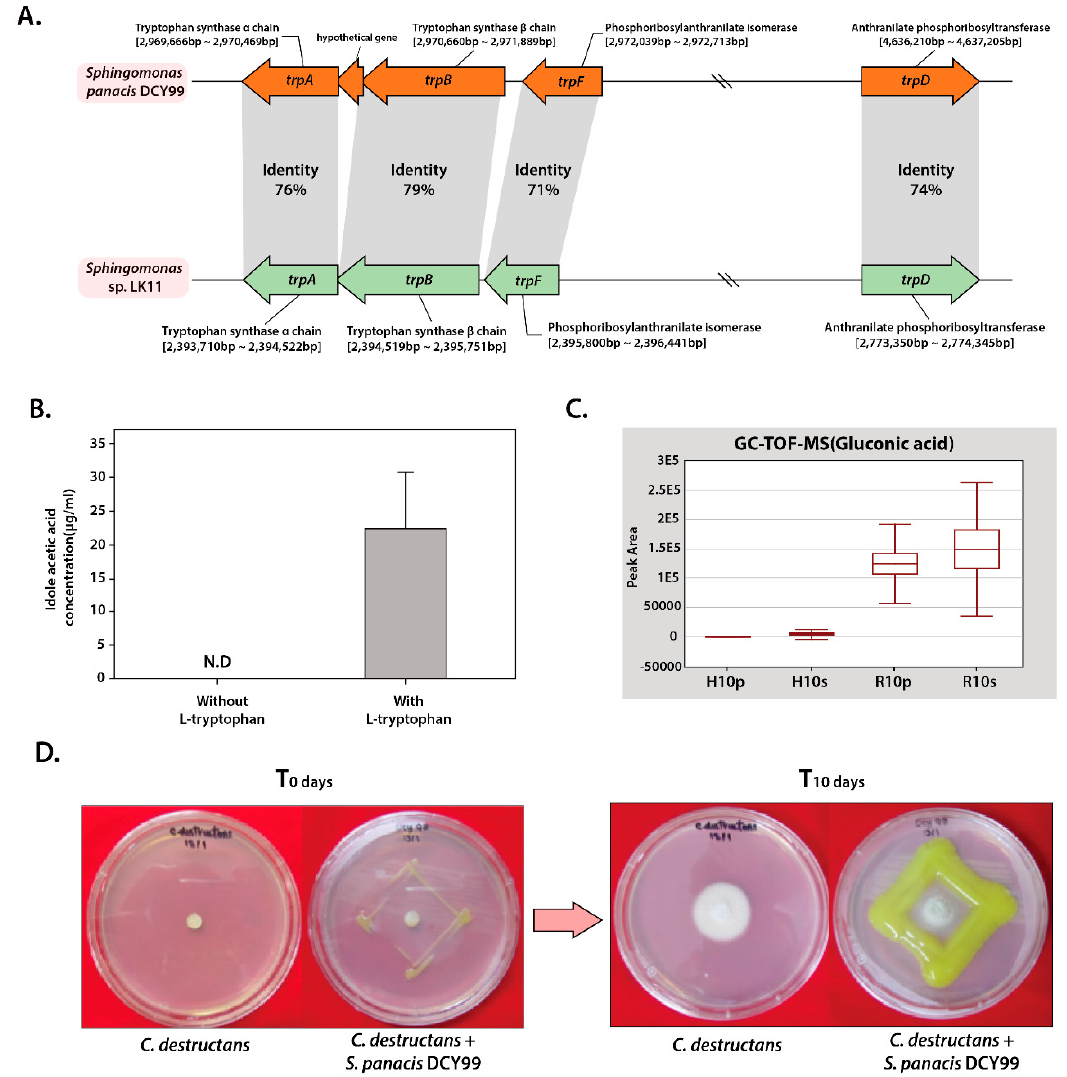
Figure 2. ( A ) Identity of trp operon between S. sp. LK11 and S. panacis DCY99 T . ( B ) Comparison of indole acetic acid production by the strain DCY99 T without L-tryptophan and with L-tryptophan, 22.4 ± 8.37 µg/mL of indole acetic acid is produced from L-tryptophan. ( C ) Results of GC-TOF-MS for D-gluconic acid from epithelium and roots of healthy and rusty 10-year-old P. ginseng (Hp, Healthy ginseng epithelium; Hs, Healthy ginseng root; Rp, Rusty-ginseng epithelium; Rs, Rusty-ginseng root). ( D ) In vitro antagonistic test against C. destructans . C. destructans cultured without and with S. panacis DCY99 T .